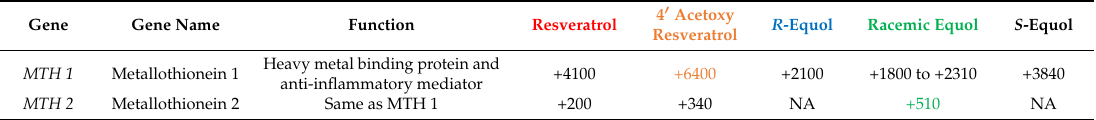
Table 7. Human skin metallothionein gene expression among resveratrol, 4 (cid:48) acetoxy resveratrol, R -equol, racemic equol or S -equol as the percentage of the increase (+) or decrease ( − ) compared to